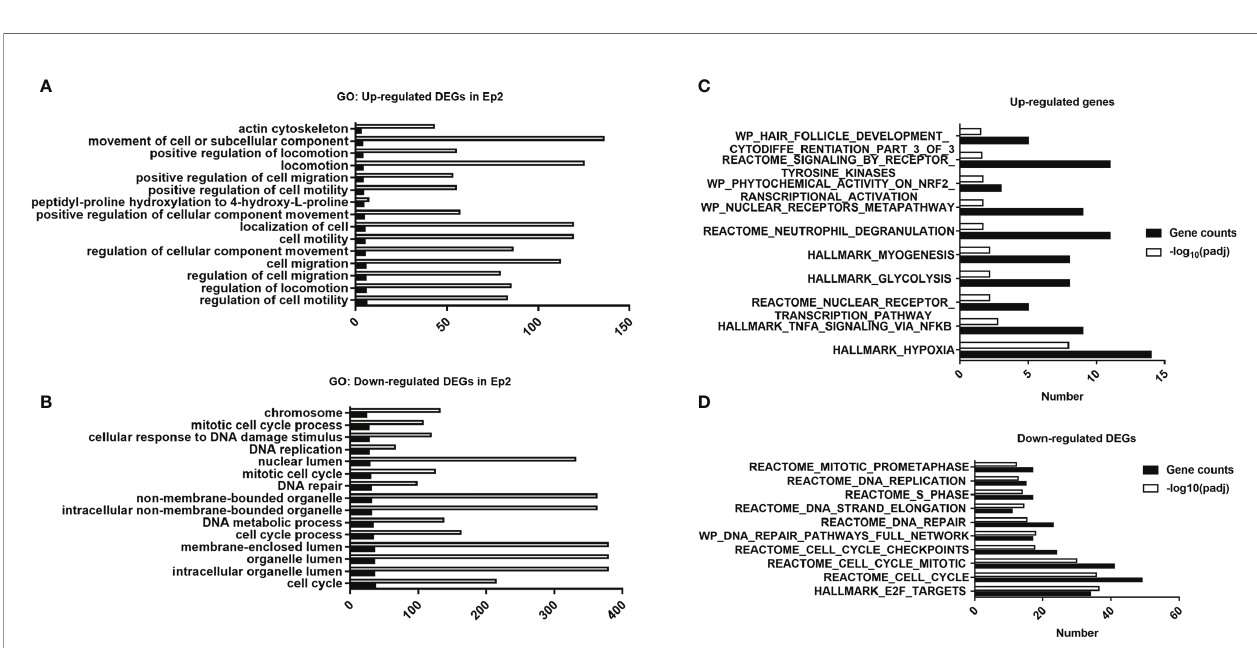
FIGURE 5 | Functional analysis of DEGs in various groups. (A) Top 15 annotations of DEGs in the Ep1 group. (B) Top 15 annotations of up-regulated DEGs in the Ep2 group. (C) Top 15 annotations of down-regulated DEGs in the Ep2 group. (C) Computed overlaps between the up-regulated DEGs and MSigDB gene sets. (D) Computed overlaps between down-regulated DEGs and MSigDB gene sets. The threshold value considered as the signi fi cant difference is p < 0.05 and FDR q-value < 0.05.